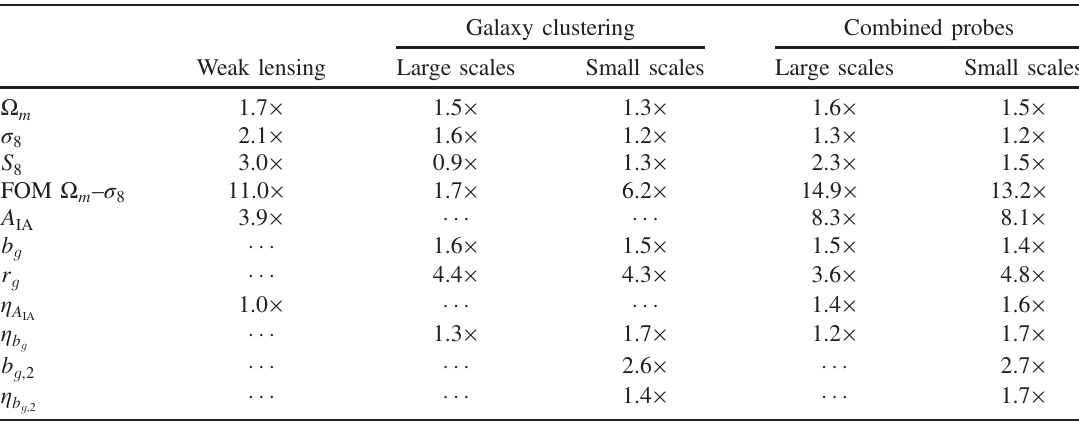
TABLE II. Measurement precision gain using with DeepLSS over the power spectrum analysis. Results for galaxy clustering and combined probes are given for two redshift-dependent smoothing scales of galaxy position maps, with FWHM of 8 and 4 Mpc/h for “ large scales ” and “ small scales, ” respectively. Weak lensing maps were always smoothed with 4 Mpc/h kernel. The difference is expressed as SD ð θ precision gain. It was calculated as a median of 200 noisy mock observations taken at the fiducial